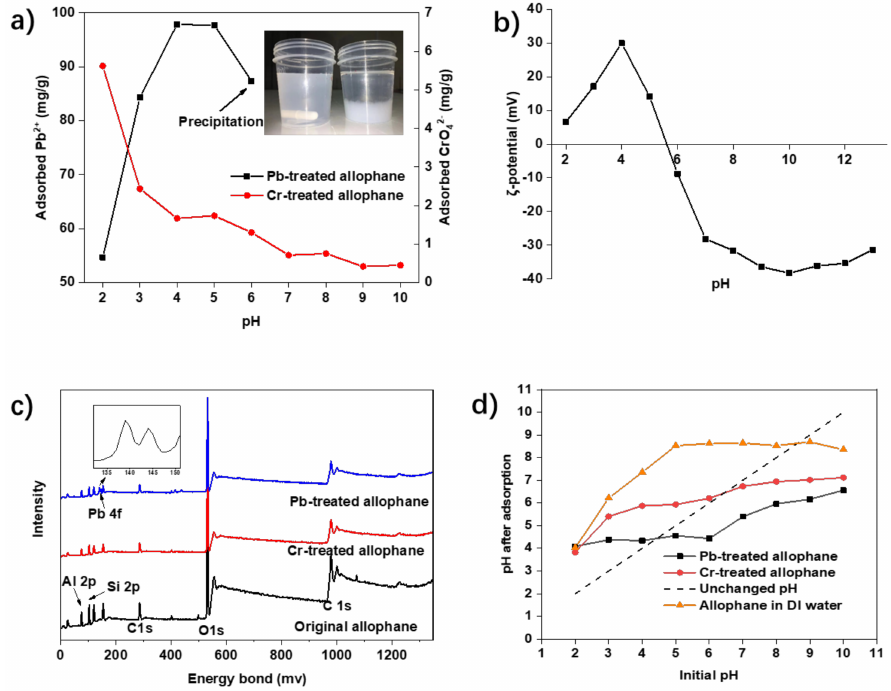
Figure 5. ( a ) Effect of pH on the adsorption of Pb 2+ and CrO 42 − onto synthetic allophane (fixed shaking time was 24 h; initial concentrations of CrO 4 2 − and Pb 2+ were 100 and 800 mg/L, respectively; dosage of the absorbent was 40 mg/L). ( b ) Zeta ( ξ ) potential of synthetic allophane. ( c ) XPS of the synthetic allophane. ( d ) pH changes in the solution of CrO 42 − and Pb 2+ by applying synthetic allophane, data from the experiment of effect of